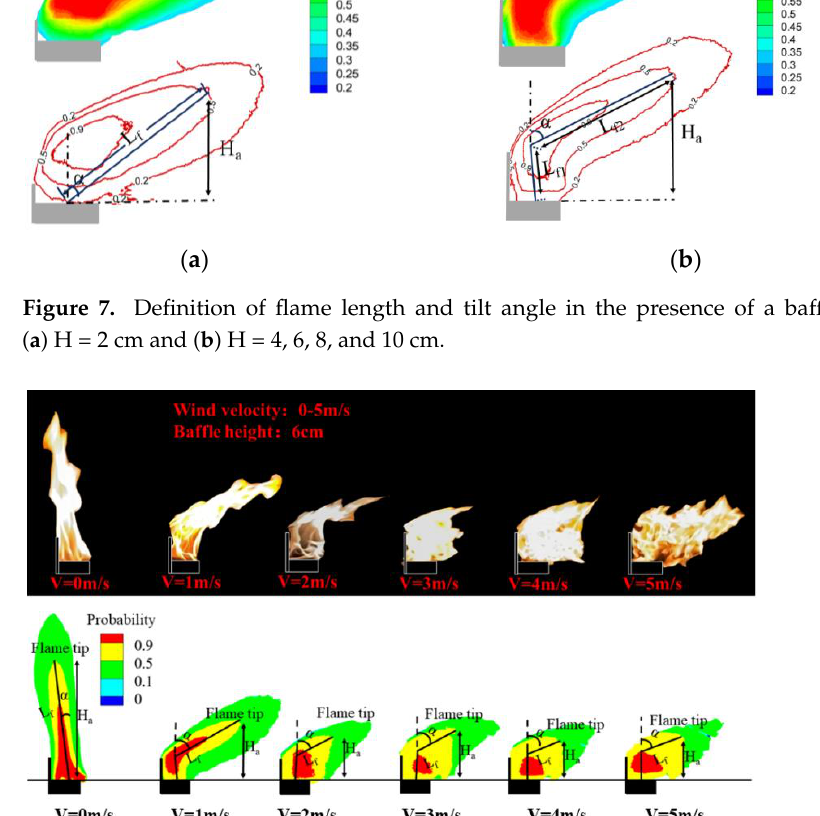
Figure 9. ( a ) Flame length of the pool fires in the experiments. ( b ) Flame height of the pool fires in the experiments and Chen ’s study [13] of flame height .